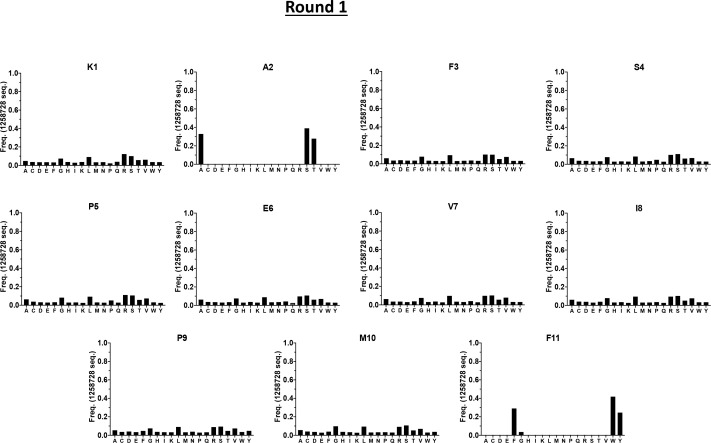
Individual amino acid frequencies of the AGA1 TCR-selected, HLA-B*57:03-restricted yeast display peptide repertoire following Round 1 selection.Individual amino acid frequencies along the length of the 11 amino acid peptide are illustrated in bar chart format, with the frequencies of peptide sequence reads represented on the Y axis. Individual amino acids at each position of the 11mer peptide are represented on the X-axis. K1, A2, F3 refers to amino acid positions 1, 2, 3, etc, of the HIV KF11 peptide sequence, which is included for reference.
Figure 2—figure supplement 2—source data 1.Amino acid signatures of Yeast display libraries-AGA1 TCR Round 1 selection.